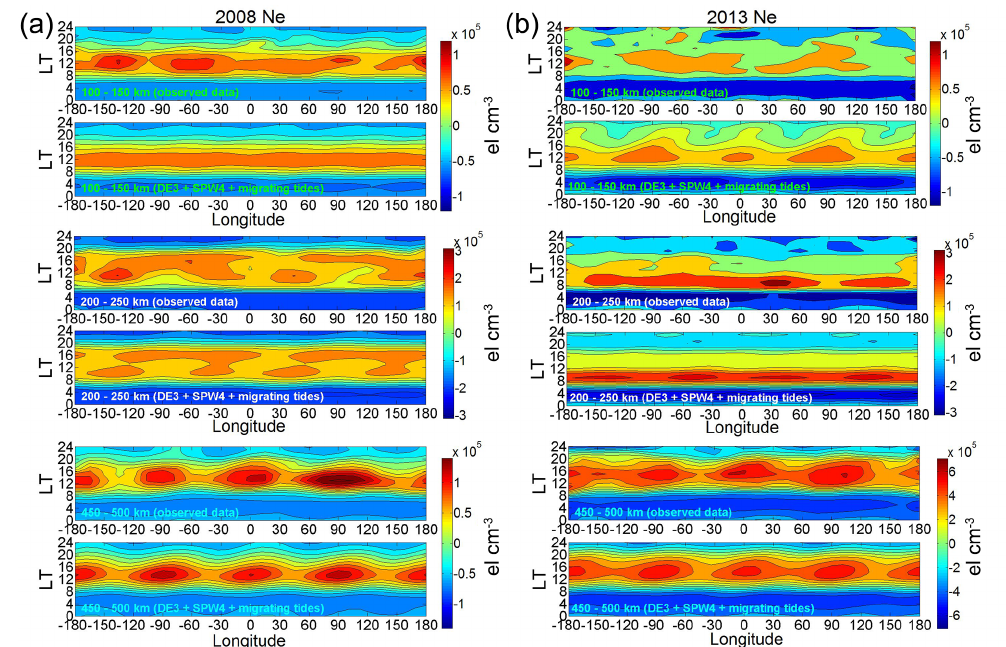
Figure 11. Observed and reconstructed Ne for 2008 and 2013 around September equinoxes. In this figure plots related to the 2008 September equinox period are in (a) panels, while those related to 2013 are in (b) panels. Three intervals were selected: 100–150, 200–250 and 450– 500km. For each one of these altitude intervals, we show the observed and reconstructed variations. The reconstructions were done using SPW4, DE3 and migrating tide waves’ (DW1, SW2 and TW3) signatures observed in the spectral analysis (not shown) at ionospheric altitudes. The altitude intervals related to each plot in the figure are identified in the plots. The best comparisons were found in the 450– 500km altitude interval for both years 2008 and